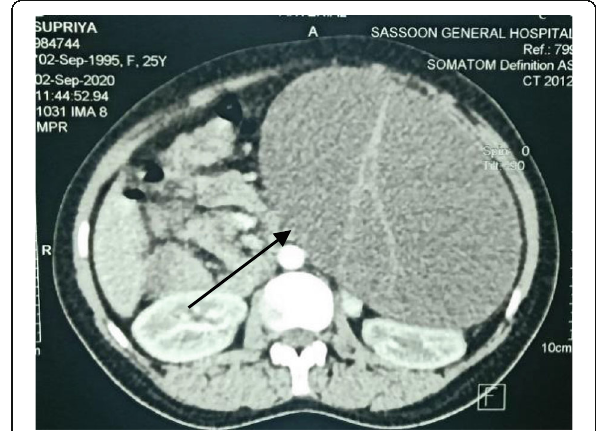
Fig. 1 Computed tomographic image scan of the case above revealed a large well defined multiloculated thin-walled cystic lesion with thin incomplete enhancing septae intraperitoneally 16.3 × 10.8 × 17.2 cm (black